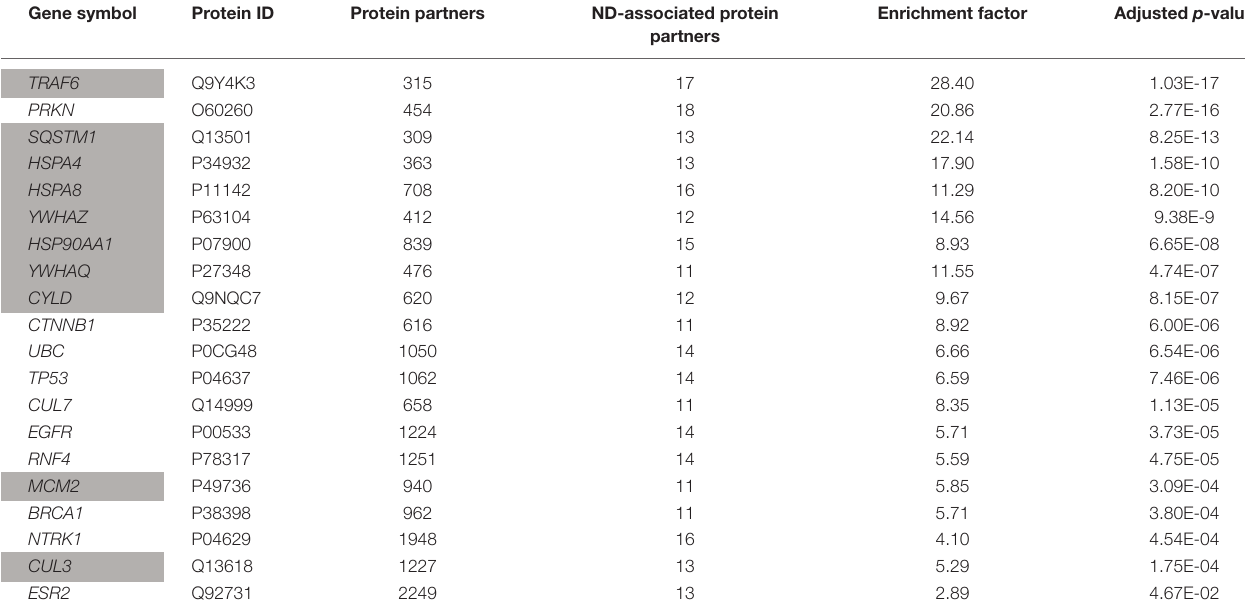
TABLE 2 | Main hub partners of common neurodegeneration-associated proteins. Gene symbol